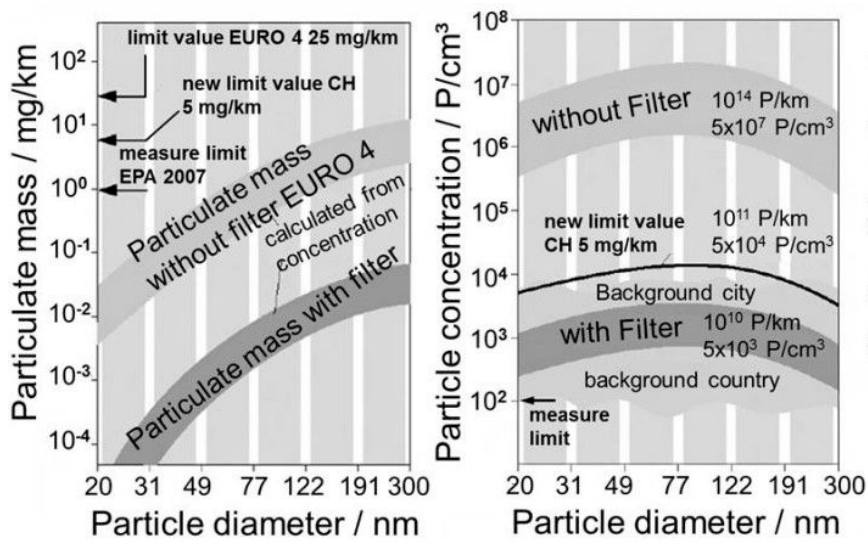
Figure 4. Diesel internal combustion engine (ICE) equipped with particulate filters as air cleaners in urban areas [49].